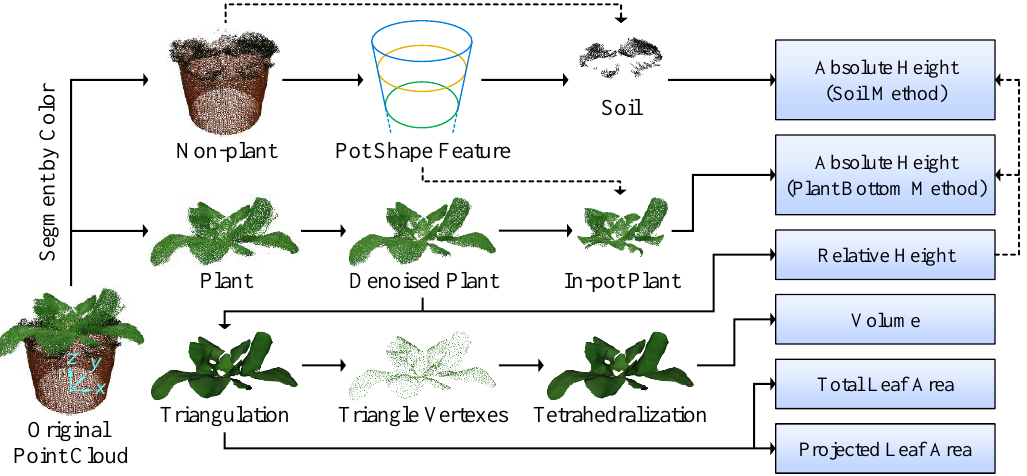
Figure 3. Main procedure of point cloud processing and plant growth parameters measurement. Solid lines are the main processes and dashed lines represent to use the information/data obtained by previous steps. The point clouds and triangular meshes appeared in this figure can be found in Supplementary Material A.